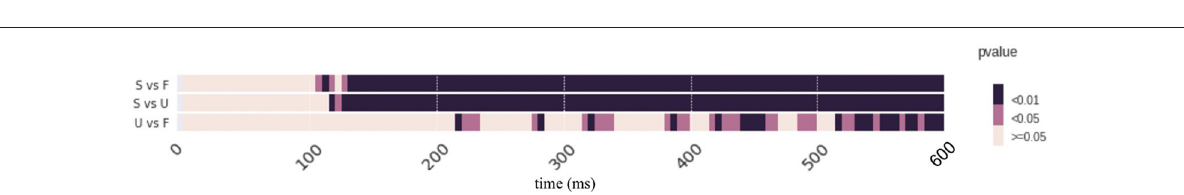
FIGURE 4 | Results of Pattern classification analysis. Pattern classification results are represented as p -values across time. Color represents the significant levels. Condition labels are the same as in Figure 1 . Both face perception conditions show differences ( p < 0.01) from the scrambled condition as early as around 120ms. Differences between two face perception conditions are scattered across the timespan. Refer to the main text for detailed